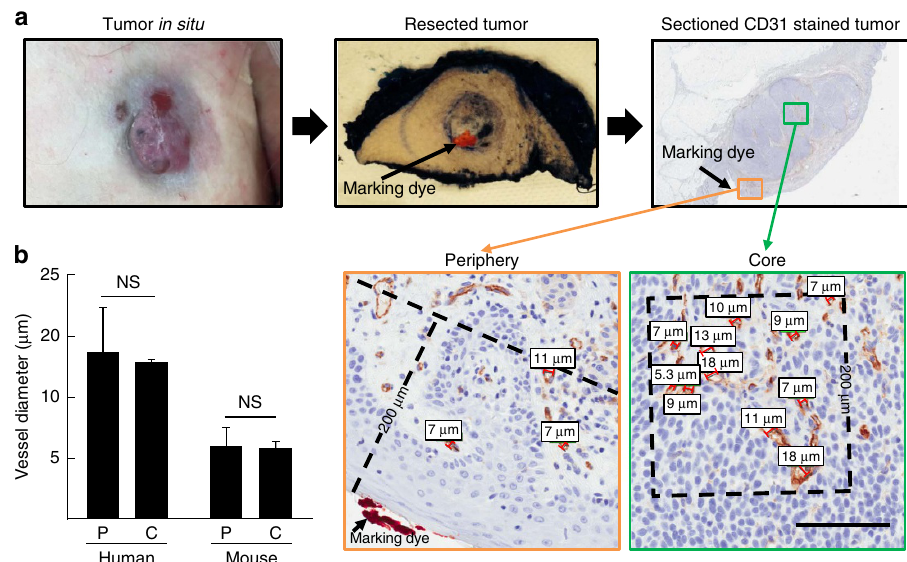
Figure 4 | Vessel diameters are similar in the periphery and core of tumours. ( a ) Marking dye was applied following surgical resection to identify the imaged surface of tumour. Measurements of core ( 4 200 m m from surface) and peripheral ( o 200 m m from surface) tumour blood vessels was performed on formalin-fixed tumour samples stained using haematoxylin and anti-CD31 mAb. Bar is 100 m m. ( b ) Comparison of tumour vessel diameters per field (minimum 5 fields) in the periphery (P) versus core (C) in humans and mice, NS, non significant (unpaired Student’s t -test). n ¼ 3 for patients; n ¼ 5 for mice. Data is mean ±